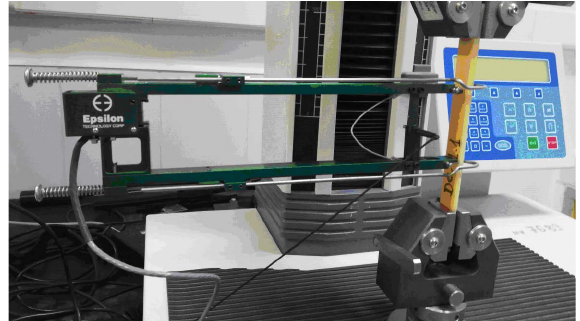
Figure 3. The tensile test assemblage of a sample from the Da 1.x